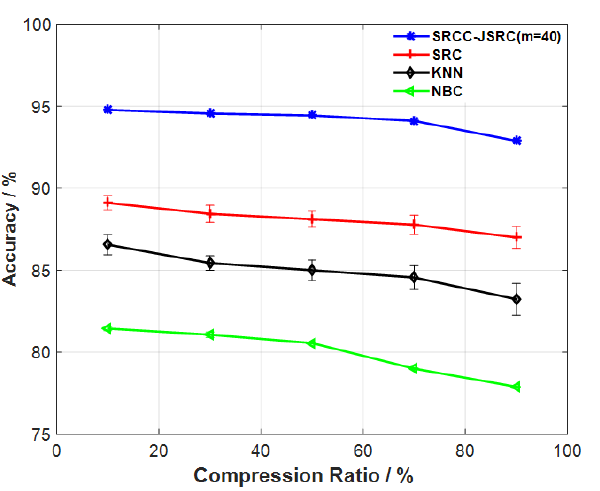
Figure 3. Comparison of accuracy of our proposed technique with KNN, naive Bayesian classifier (NBC), and sparse representation classification (SRC).